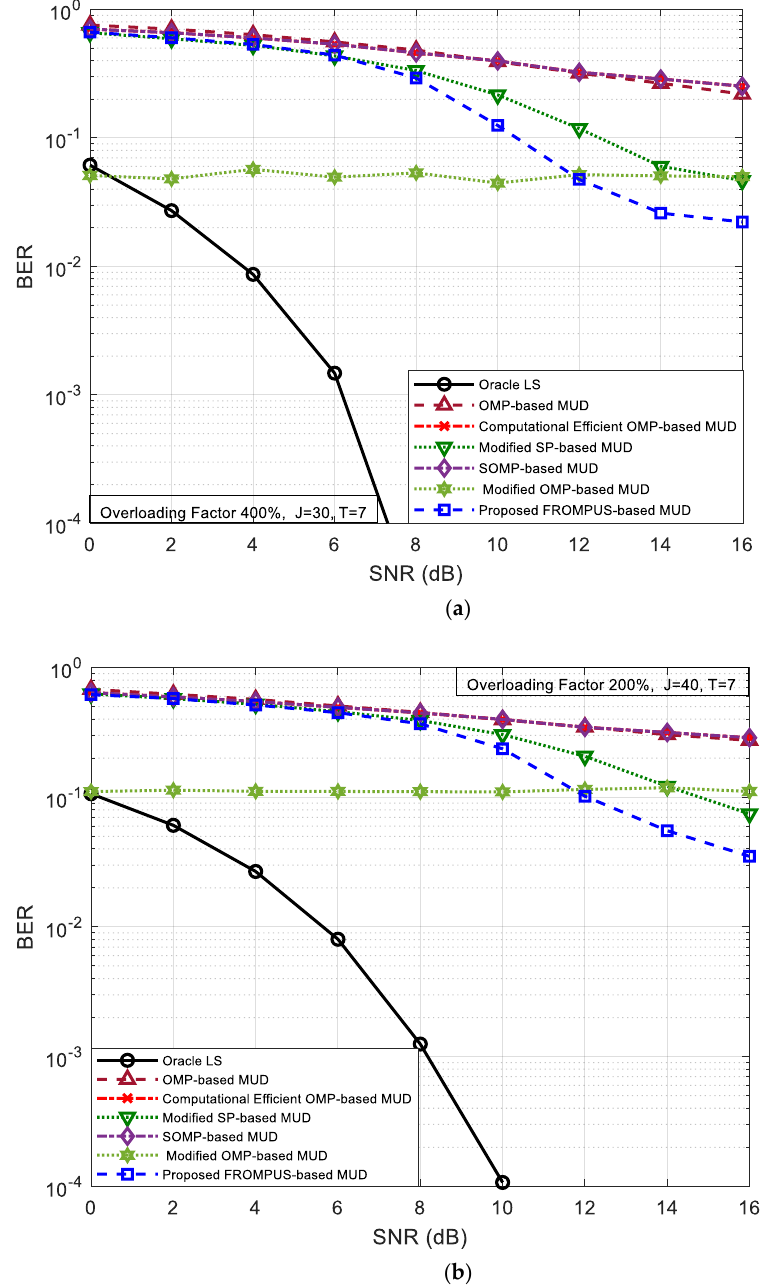
Figure 7. Achievable BER versus SNR performance of the FROMPUS-based MUD in comparison with five other MUDs, 𝑇 = 5: ( a ) overloading factor= 400%, ℑ = 30; ( b ) overloading factor= 200%, ℑ = 40 .